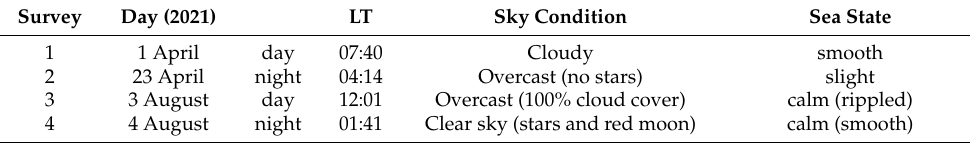
Table 1. Details of four field surveys, LT = UTC + 1; location: Thurso Bay (58.5987 ◦ N, 3.5166 ◦